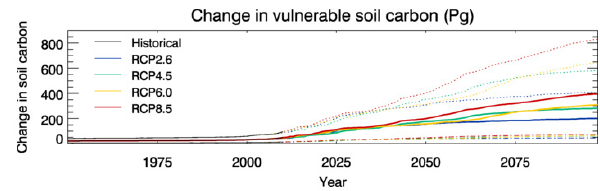
Figure 4. Time series of vulnerable soil carbon for the four RCP scenarios. The solid Fig. 4. Time series of vulnerable soil carbon for the four RCP sce- lines show the vulnerable carbon using the soil organic carbon contents from Tarnocai et narios. The solid lines show the vulnerable carbon using the soil al. (2009), the dotted lines use the maximum soil organic carbon content used within the organic carbon contents from Tarnocai et al. (2009), the dotted lines Monte Carlo simulations and the dashed lines the minimum. use the maximum soil organic carbon content used within the Monte Carlo simulations, and the dashed lines the minimum.